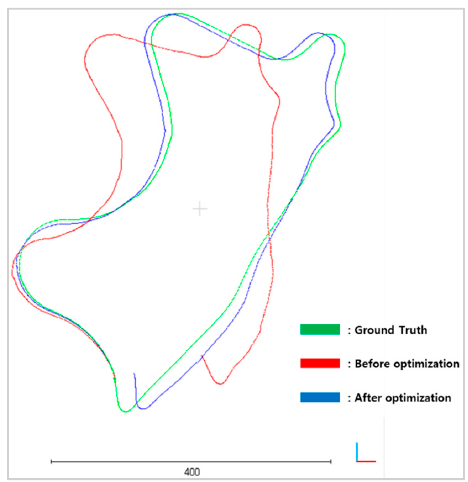
Figure 13. Estimated trajectory based on whether or not optimization is performed. Table 3. Accuracy with or without optimization.